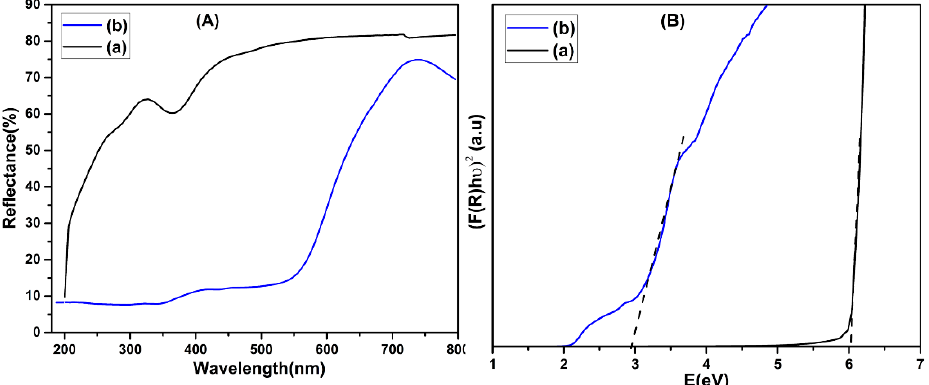
Figure 5. FT − IR spectra of ( a ) HAP and ( b ) HAP − MnFe 2 O 4 .